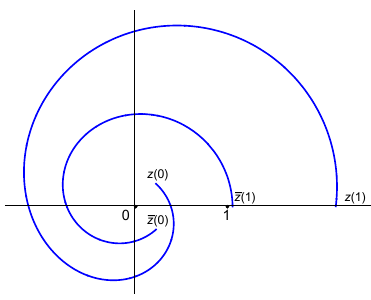
Figure 7 . The curves z ( (cid:18) ) and z ( (cid:18) ) for the causal ordering y 3